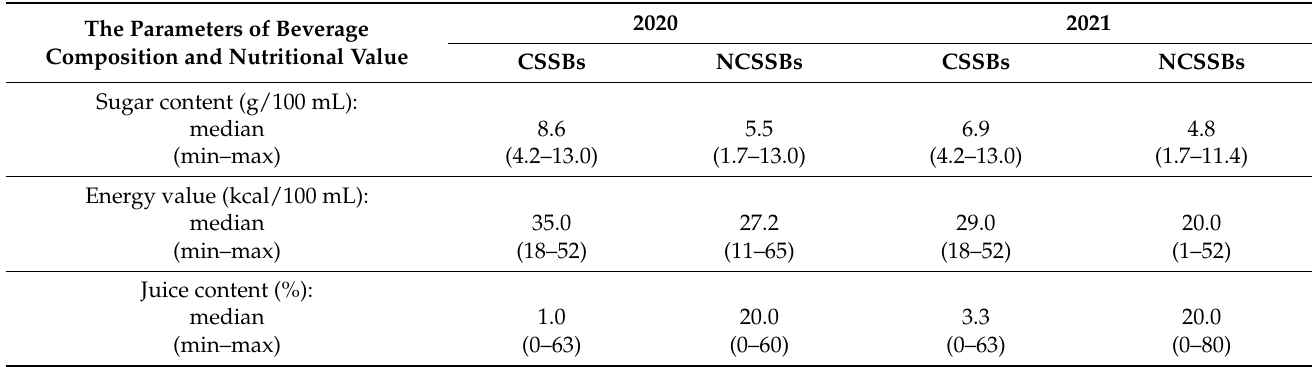
Table 1. The characteristics of SSBs in both study periods.